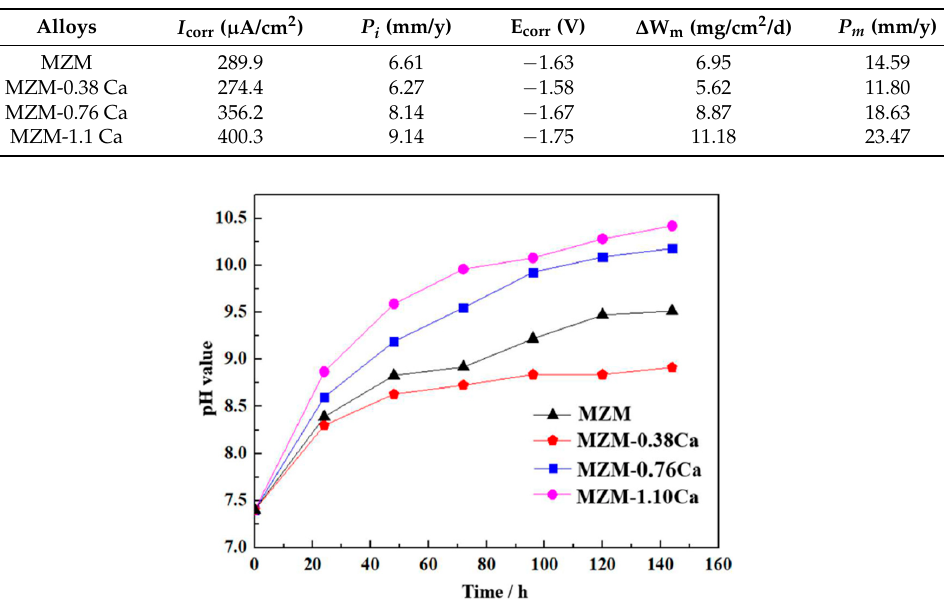
Figure 10. pH value of the studied alloys during the immersion test in Kokubo solution.